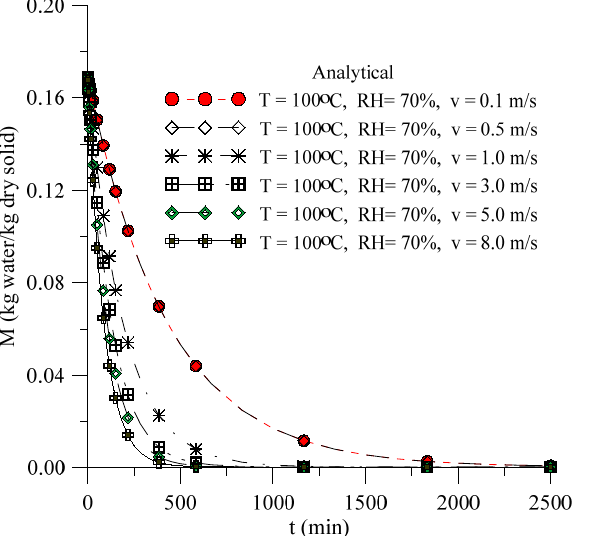
Figure 9. Average moisture content of industrial ceramic brick as a function of time for different drying air speeds.